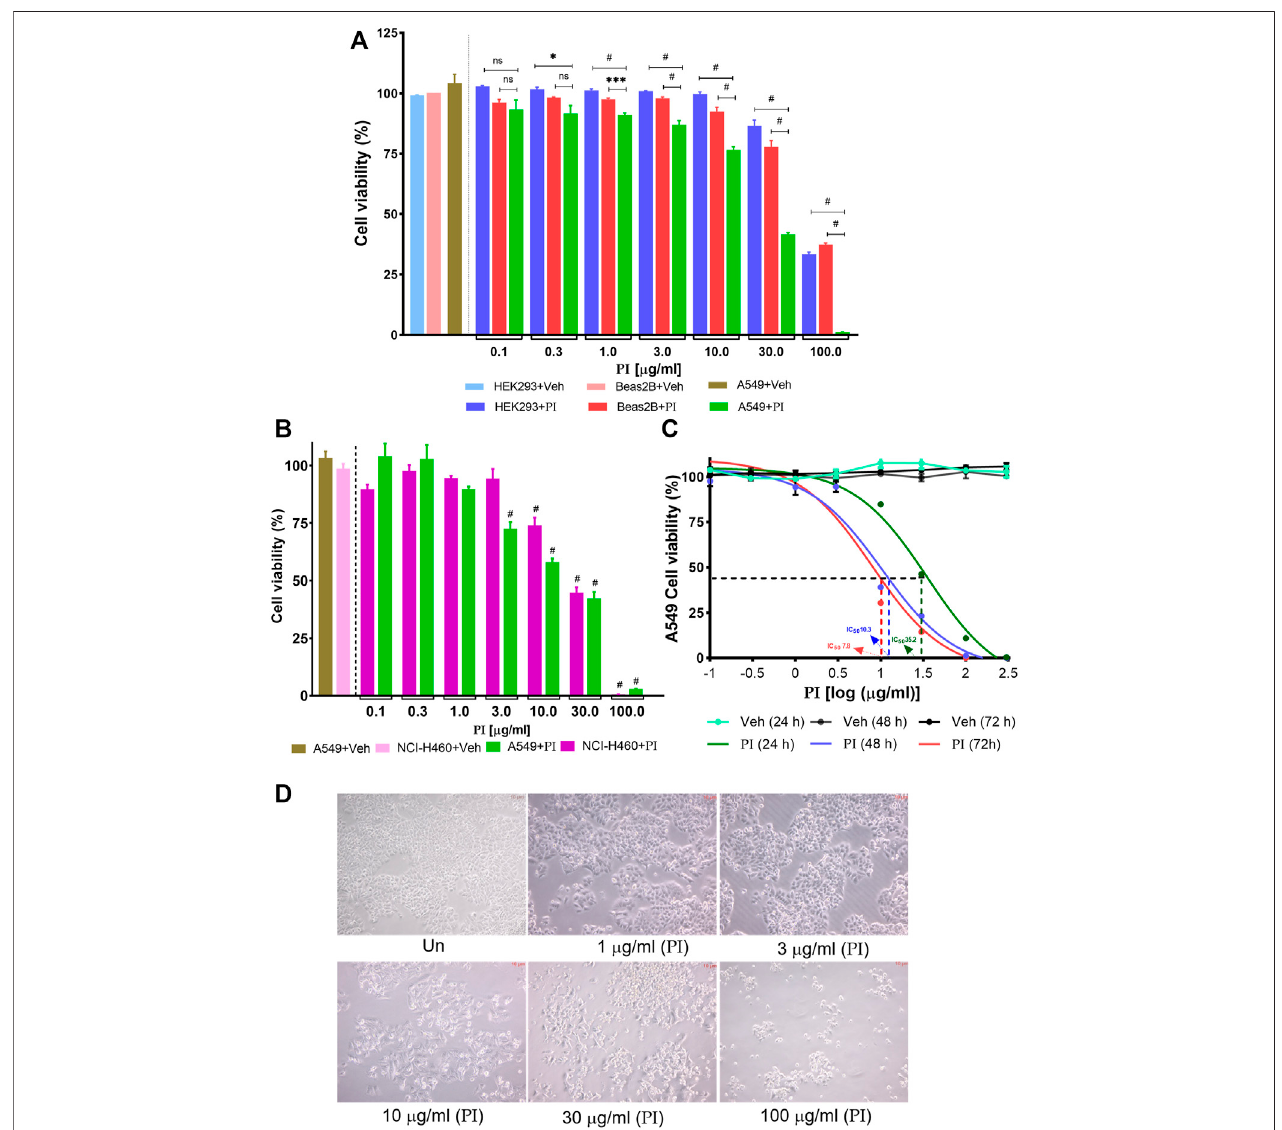
FIGURE 1 | Pistacia integerrima induces selective toxicity in non-small cell lung cancer cells. Cytotoxic effects of different PI concentrations post 24 h of treatment were assessed with Alamar blue. Percent cell viability with respect to untreated wascalculated in vehicleand treated conditions. DMSO of0.9% present in 300 μ g/ml of PI (3 times of maximum dose) served as vehicle control in all cell viability assays. (A) Percent cell viability of PI in HEK293, Beas2B, and A549 cells ( n = 3). A signi fi cant difference was evaluated in A549 with respect to HEK and Beas2B percent cell viability. (B) Percent cell viability in NCI-H460 and A549 cells ( n = 3). A signi fi cant differencewasevaluatedinA549andNCI-H460withrespecttotheirrespectivevehiclecontrol.Two-wayANOVAemployingTukey ’ smultiplecomparisontest( α =0.05) was used to analyze signi fi cant difference in the cell viability of treated cells. Error bars represent mean ± SEM; signi fi cance of data was represented as * p < 0.05, *** p < 0.0005, # p < 0.0001and notsigni fi cant(ns) if p > 0.05. (C) A549cells weretreated withPIfor24,48, and 72 h. Thelog( μ g/ml)concentrations − 1, − 0.5, 0,1,1.5, 2,and 2.5 correspond to 0.1, 0.3, 1, 3, 10, 30, 100, and 300 μ g/ml of PI ( n = 3). The half maximal inhibitory concentration (IC 50 ) of PI was evaluated by fi tting the non-linear regression dose – response curve on PI-treated curves in GraphPad 8.0. Broken lines (---) mark the IC 50 on the non-linear fi t. (D) . Bright fi eld images of A549 cells post 24 h of PI treatment at indicated concentrations. Images were captured under the inverted microscope at 40 × magni fi cation.